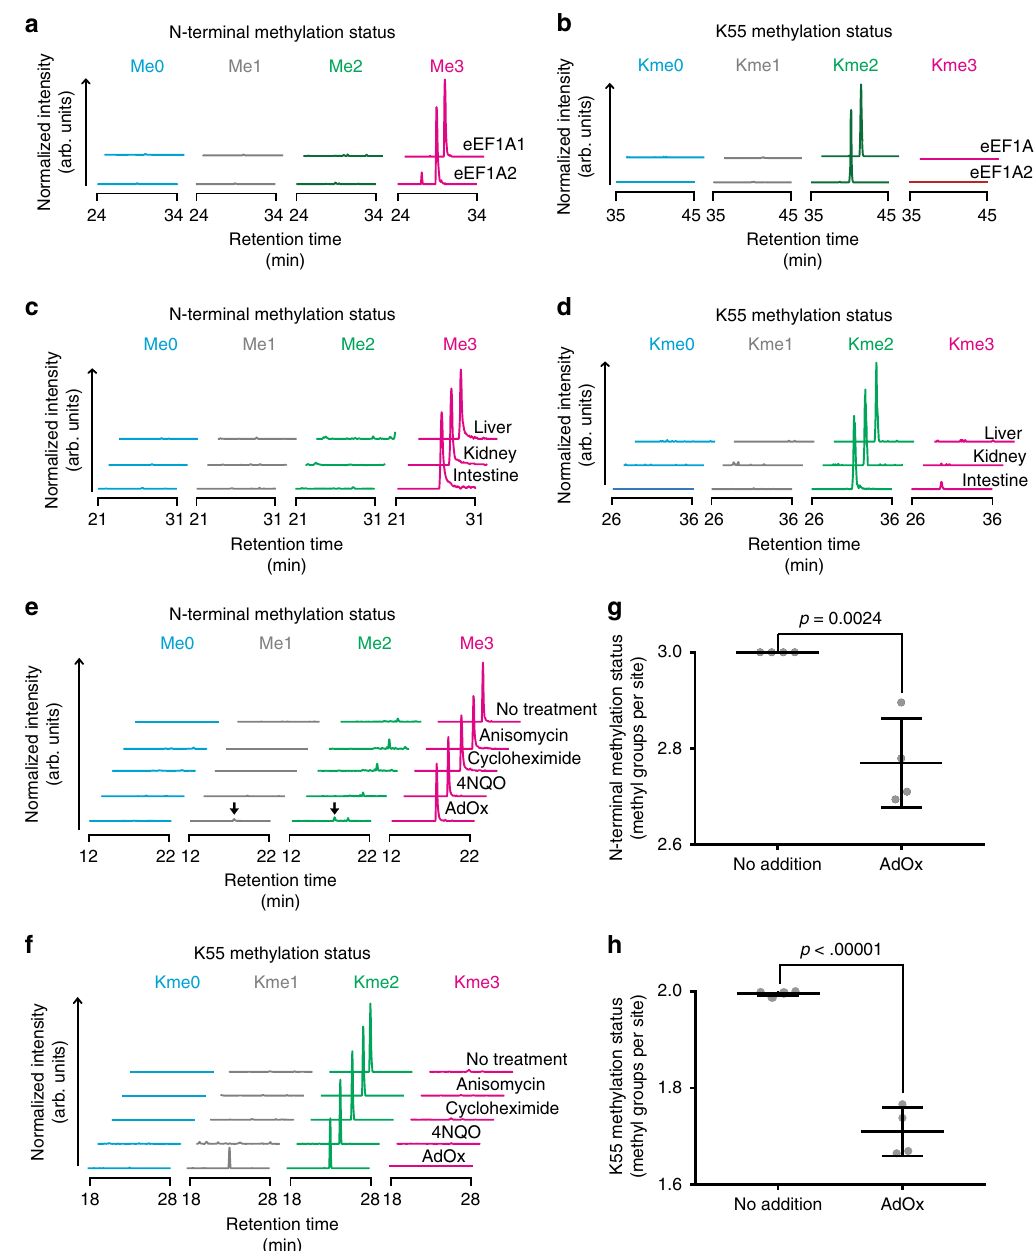
Fig. 6 METTL13-mediated methylation in cells and tissues. a , b Individual assessment of the methylation status of eEF1A1 and eEF1A2 in human cells. FLAG-tagged eEF1A1 and eEF1A2 were overexpressed in HEK-293 cells and the methylation status of the N terminus ( a ) and Lys55 ( b ) was assessed by MS. c , d Assessment of the methylation status of eEF1A proteins in a panel of rat tissues. Same as in previous panels, but ion chromatograms represent the collective methylation status of both eEF1A1 and eEF1A2 in rat liver, kidney, and intestine. e , f Assessment of eEF1A methylation in HeLa cells stressed by various compounds. Ion chromatograms representing the methylation status of eEF1A in cells treated with anisomycin, cycloheximide, 4NQO, and AdOx are shown. Peaks corresponding to the mono- and dimethylated forms of the eEF1A N terminus are indicated (arrow). g , h Quantitative analysis of eEF1A methylation in HeLa cells treated with AdOx. Signi fi cance was assessed using a two-tailed t -test and error bars represent the s.d., n = 4 eEF1A lysine methylation in modulating its interactome. To this Fig. 14a, b and Supplementary Data 5 – 6) and, importantly, that end, we overexpressed af fi nity-tagged WT eEF1A and corre- interactants for both bait proteins were enriched with a sponding methylation-de fi cient mutant, carrying lysine-to- comparable ef fi ciency (Supplementary Fig. 14c, d). We conclude arginine mutations of the well-established methylation sites that lysine methylation of eEF1A is not a strong determinant of (Lys36, Lys55, Lys79, Lys165, and Lys318) in HEK-293 cells its interactome. and quanti fi ed co-purifying proteins. We found that both WT In summary, we observed codon-speci fi c changes in translation and methylation-de fi cient eEF1A ef fi ciently enriched components rate when comparing METTL13 KO cells to the corresponding of the eEF1 complex (EEF1B2, EEF1G, and EEF1D) as well as WT and conclude that these alterations are likely due to the lack aminoacyl-tRNA synthetases (VARS and CARS) (Supplementary of methylation at the N terminus and Lys55 in eEF1A. NATURE COMMUNICATIONS| (2018) 9:3411 |DOI: